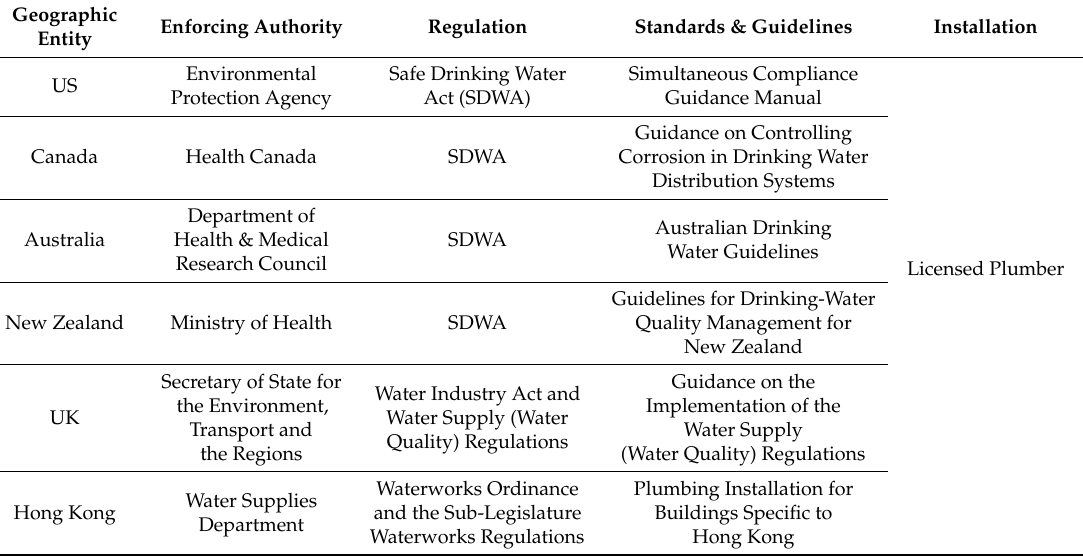
Table 1. Comparison of legislation structure and relevant standards in various